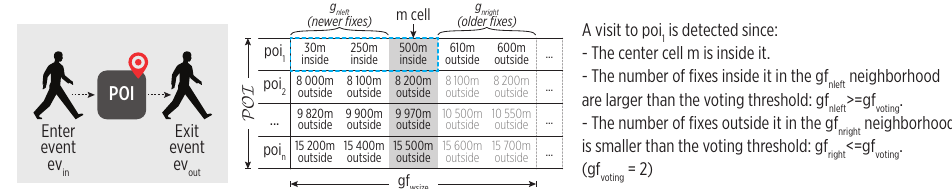
Figure 3. The Geofencing mechanism ( gf ). An enter to poi 1 is detected since we observe that newer (left) fixes are inside it and older fixes (right) are outside it.